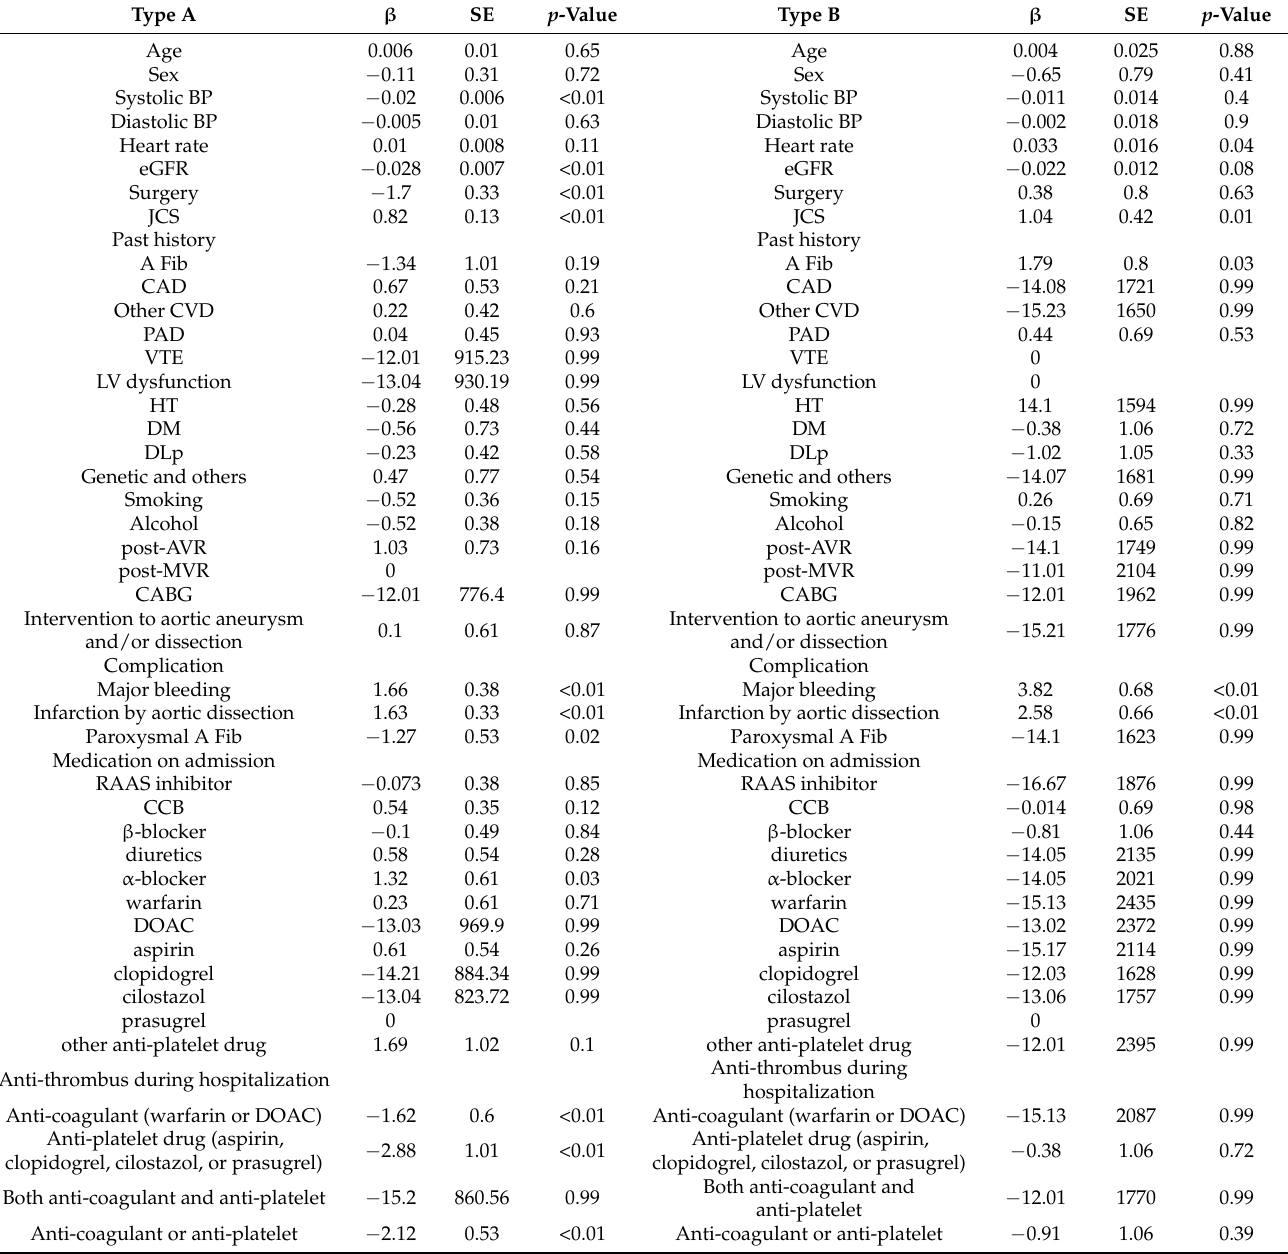
Table 9. Cox proportional hazard model for all-cause mortality in HOSPITALIZED acute aortic dissection